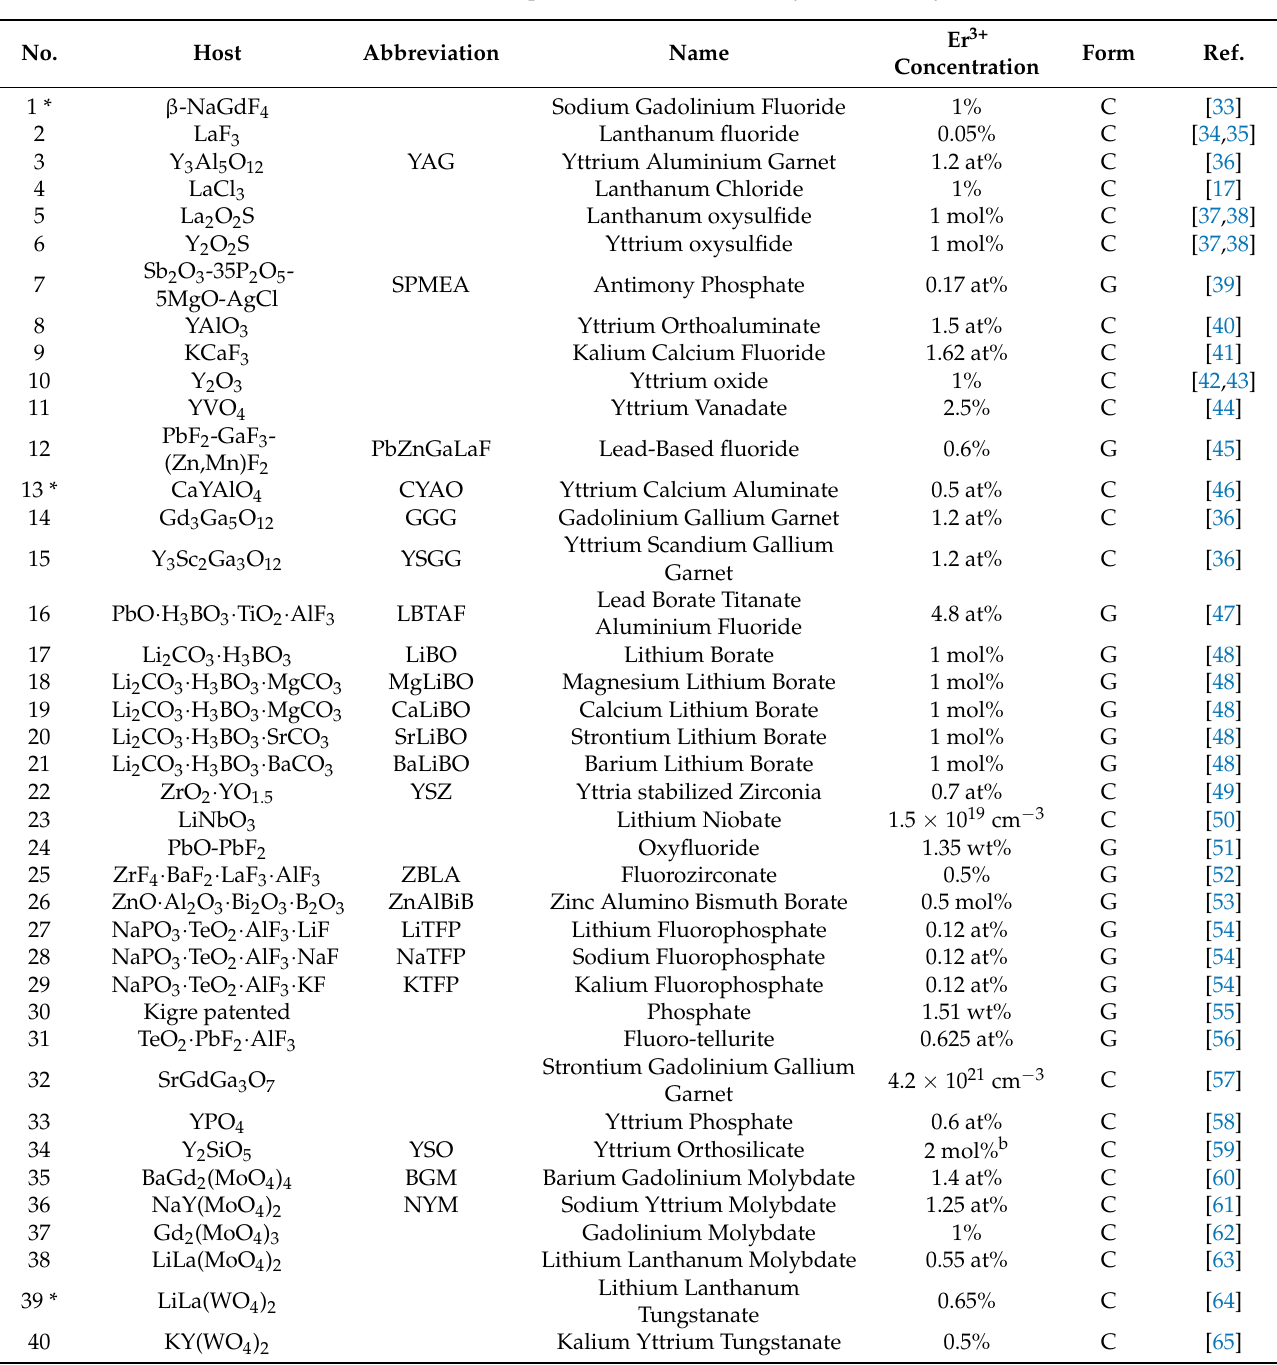
Table 1. A collection of 40 Er 3+ doped hosts used in this study. Form: C–Crystal, G–Glass.